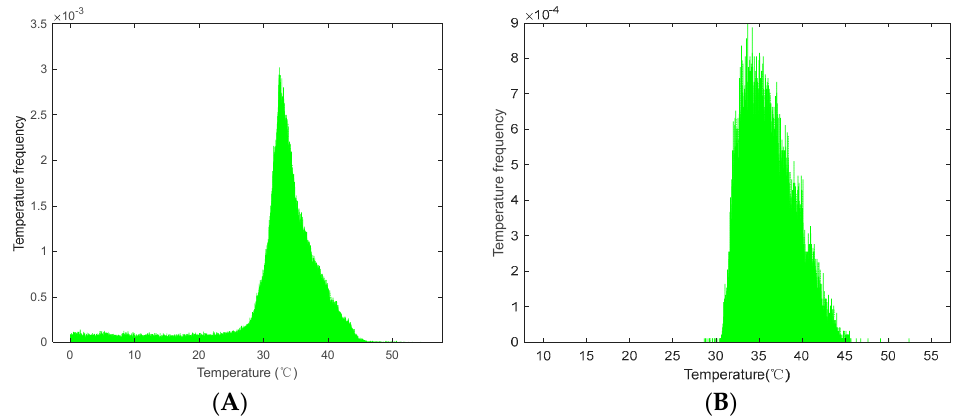
Figure 5. Temperature histogram of a sample vine ( A ) with the original thermal image and ( B ) with the masked thermal image.